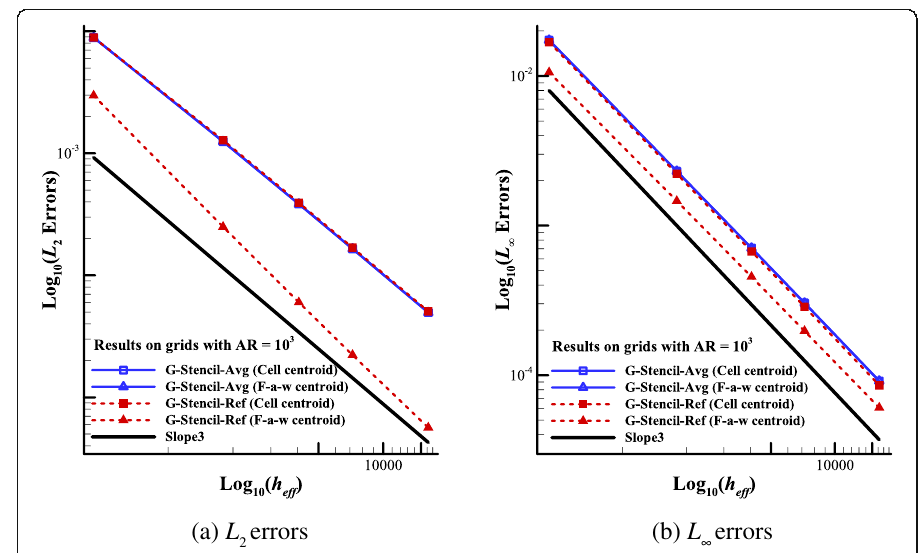
Fig. 42 ( a ) L 2 and ( b ) L ∞ errors. Cell-averaged and point-valued discretization errors of G-Stencil with the geometric centroid and face-area-weighted centroid on grids with AR = 10